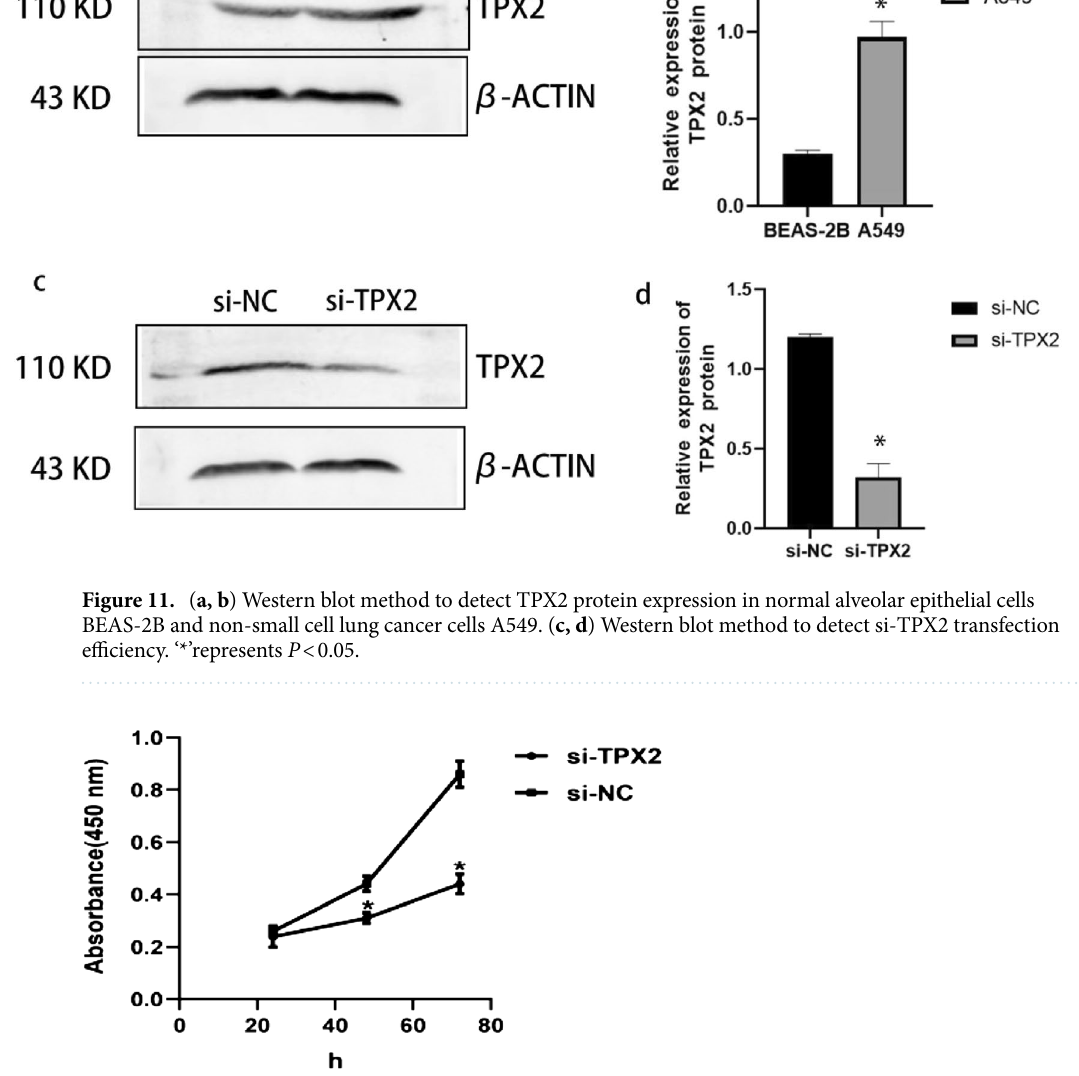
Figure 12. CCK8 method to detect the proliferative ability of the si-NC and si-TPX2 groups. Silencing of TPX2 inhibited the proliferative capacity of A549 cells. ‘*’ represents P <